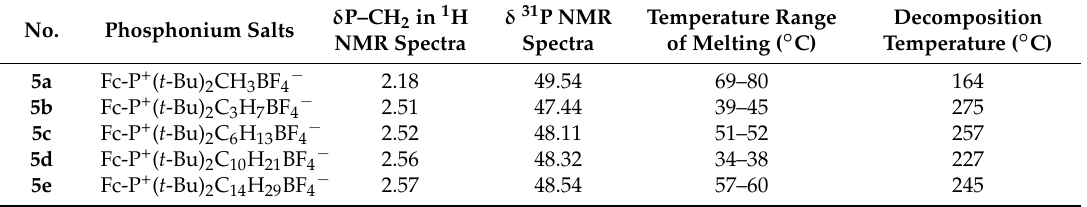
Table 5. 1 H and 31 P chemical shifts of Fc-containing phosphonium salts 5a – e a .